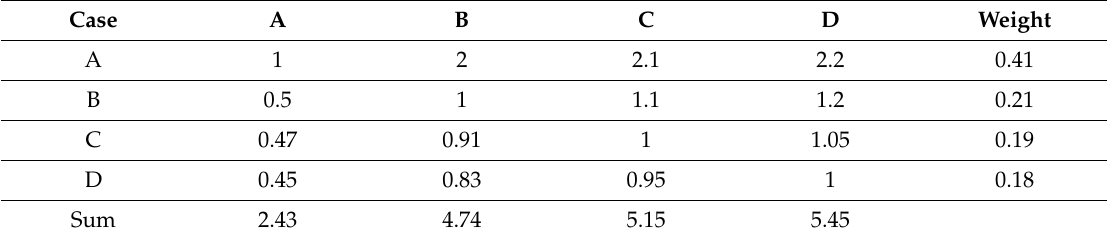
Table A2. Pairwise comparison of alternatives based on Economics.